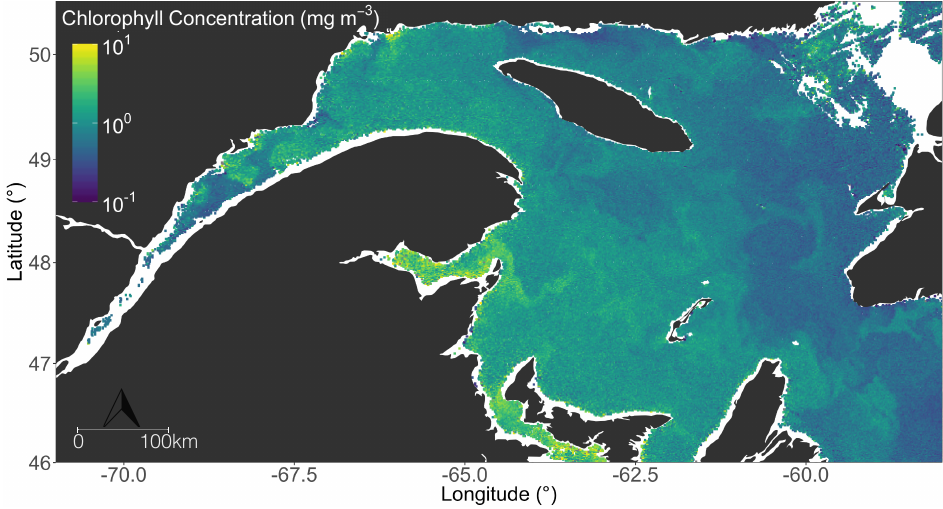
Figure 6. SLEG chlorophyll for 12 October 2003, as predicted by the EOF